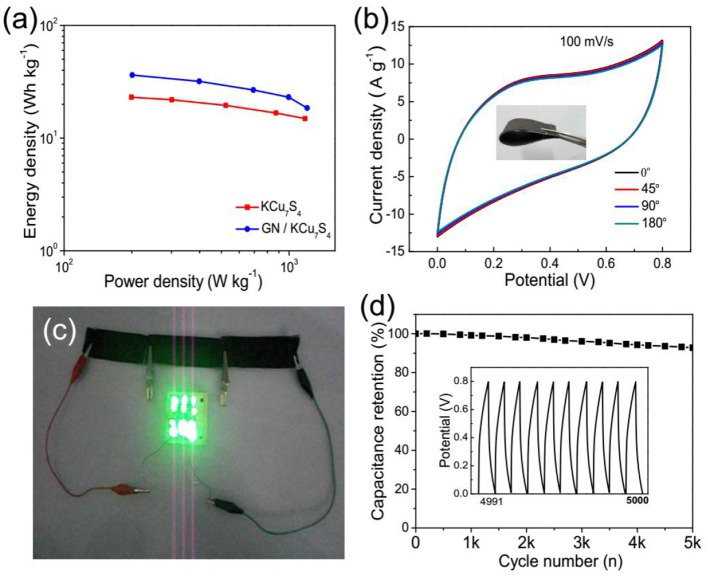
(a) Ragone plots of the prepared KCu7S4 /CFF and GN/KCu7S4/CFF SCs. (b) CV curves of the GN/KCu7S4/CFF SC at different curvatures of 0o, 45o, 90o, and 180o. (c) Optical photograph of 12 commercialized LEDs lighted by three GN/KCu7S4/CFF SCs connected in series. (d) Cycling life of the GN/KCu7S4/CFF SC.